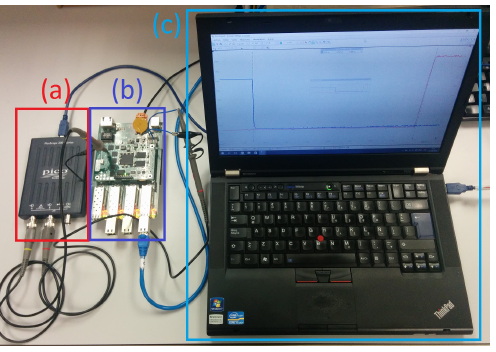
Figure 8. Snap-shoot of SmartZynq COEsec concept-proof set-up. ( a ) Multiport oscilloscope. ( b ) SMART zynq Industrial Networking card. ( c ) PC for sending and receiving the COE sec